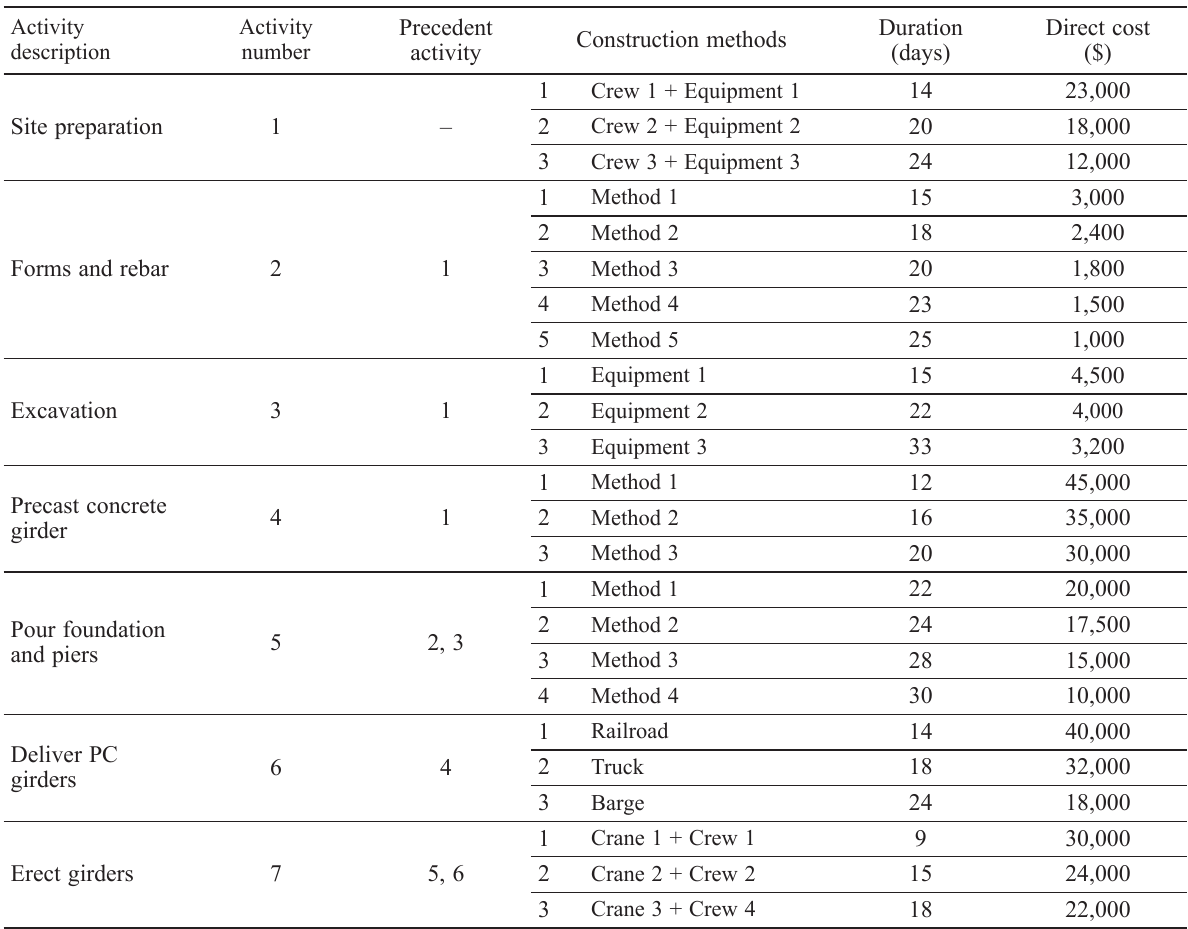
Table 1. Description of the case study Activity